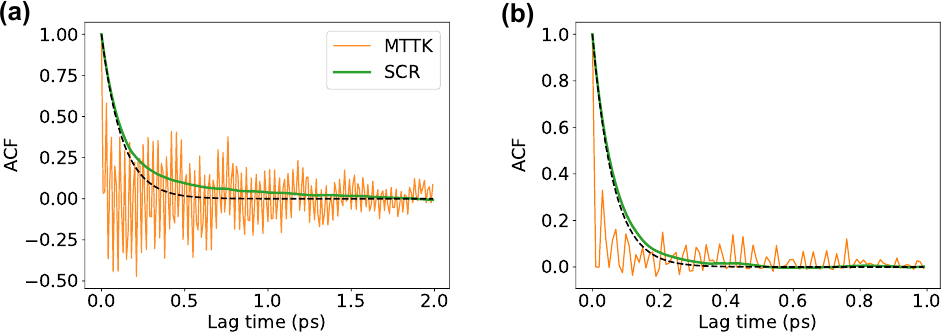
τ P . β T ( 2 τ ) . P β T